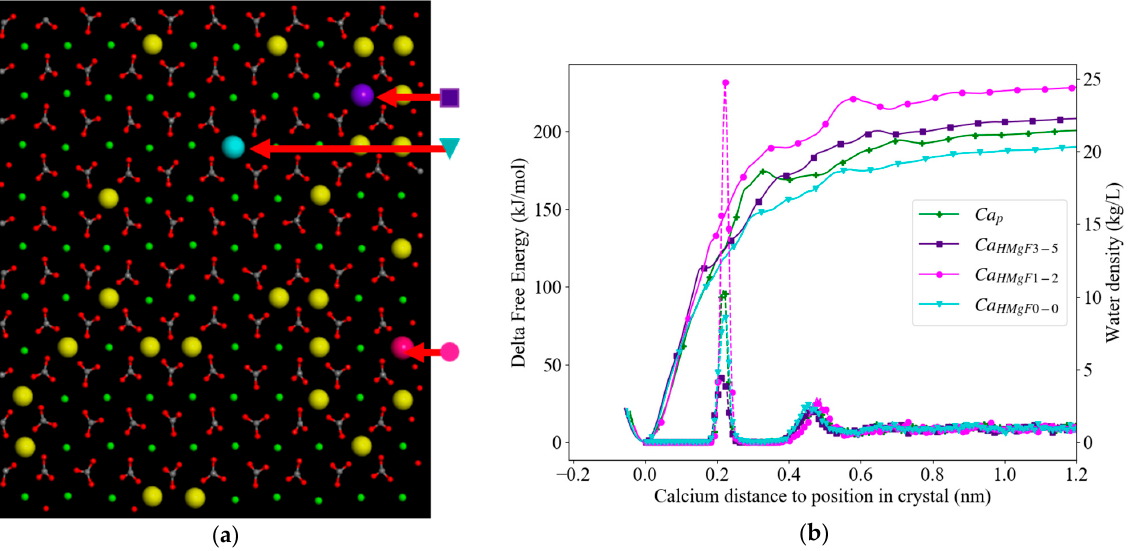
Figure 5. ( a ) Top view of HMgF 1014 surface with Mg 2+ in yellow, carbonate groups in grey (C) and red (O) and Ca 2+ in small green or colour-coded (cf. Table 3) larger spheres to link them to the free energy profiles in purple ( ), turquoise ( ▼ ) and pink ( ● ). ( b ) Overlay of free energy profiles (continuous line, left y -axis) of calcium ions extracted from their equilibrium position in the crystal (0.0 nm) with the water z -density (dashed line, right y -axis) along the same axis. The colours are referring to the corresponding Ca 2+ equilibrium position in the left image and Ca 2+ in pure calcite in green (+).